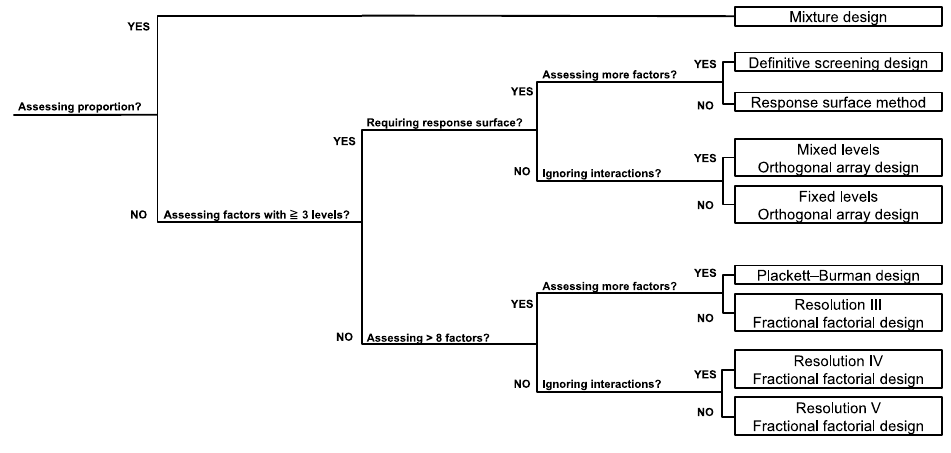
Figure 2. Decision tree for DOE selection.